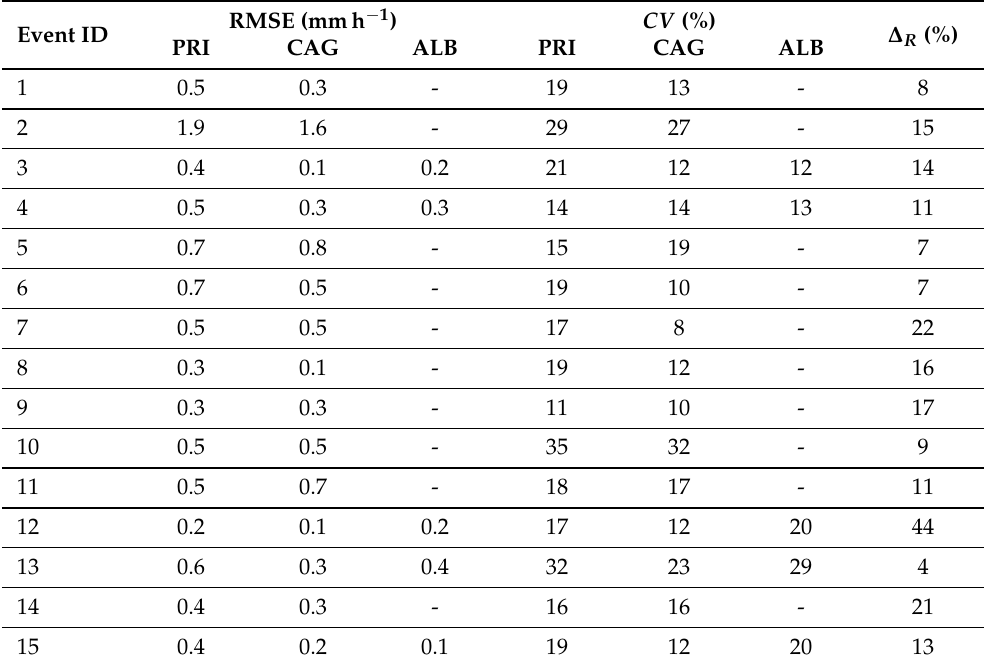
Table 4. Performance of the power-law fit to the γ - R relationship, as estimated through disdrometer data (CAG, ALB and PRI). The indicators CV and ∆ R are defined in Equations (6) and (7), respectively. Frequency: 18.8 GHz, polarization: V, horizontal